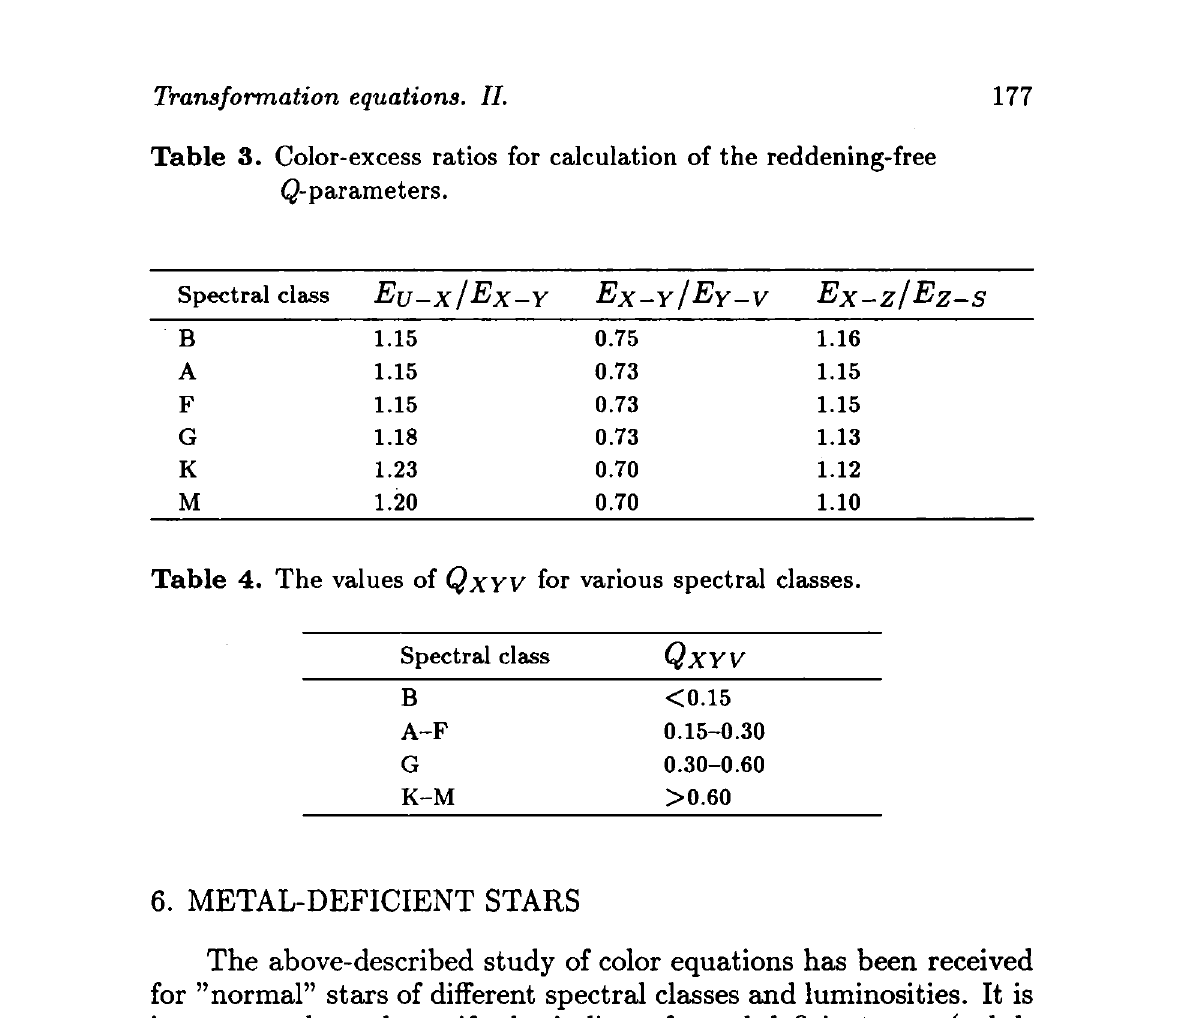
Table 3. Color-excess ratios for calculation of the reddening-free Q-parameters.